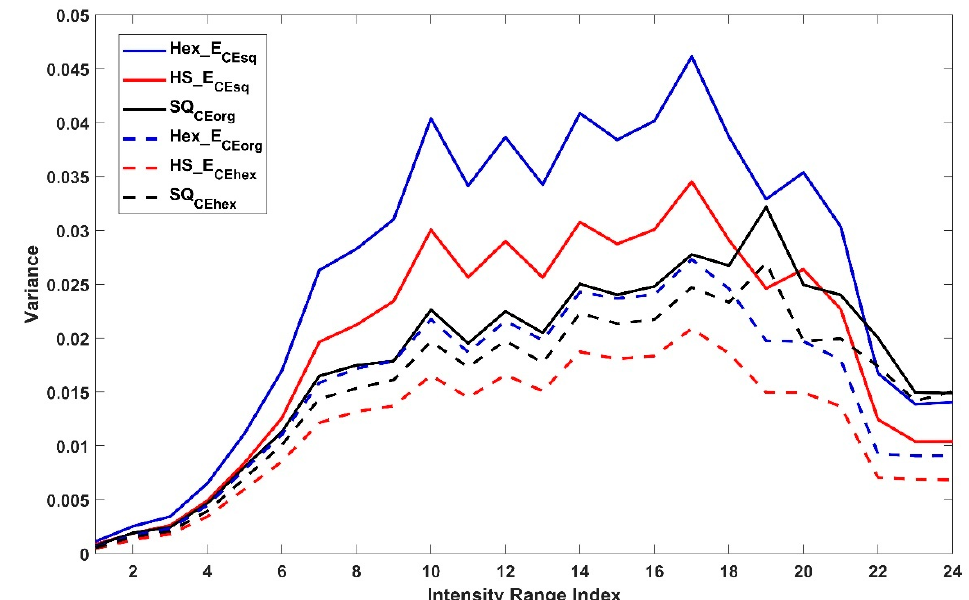
Figure 12. Intensity average of ten corresponding pixel sets of each 𝐻𝑒𝑥_𝐸 (cid:3004)(cid:3006)(cid:3046)(cid:3044) , 𝐻𝑆_𝐸 (cid:3004)(cid:3006)(cid:3046)(cid:3044) , 𝑆𝑄 (cid:3004)(cid:3006)(cid:3042)(cid:3045)(cid:3034) or 𝐻𝑒𝑥_𝐸 (cid:3004)(cid:3006)(cid:3042)(cid:3045)(cid:3034) , 𝐻𝑆_𝐸 (cid:3004)(cid:3006)(cid:3035)(cid:3032)(cid:3051) , 𝑆𝑄 (cid:3004)(cid:3006)(cid:3035)(cid:3032)(cid:3051)